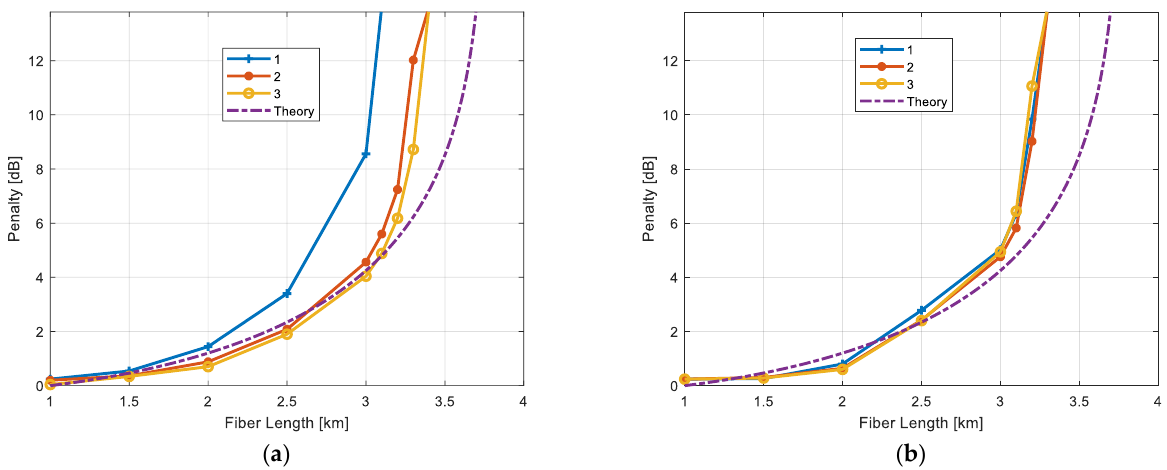
Figure 11. Attenuation penalty vs. fiber length (km) of PAM-4 with SG filter orders of 1, 2, 3, and theory (Equation (34)) with 3 dB BW at ( a ) 40 GHz and ( b ) 80 GHz.